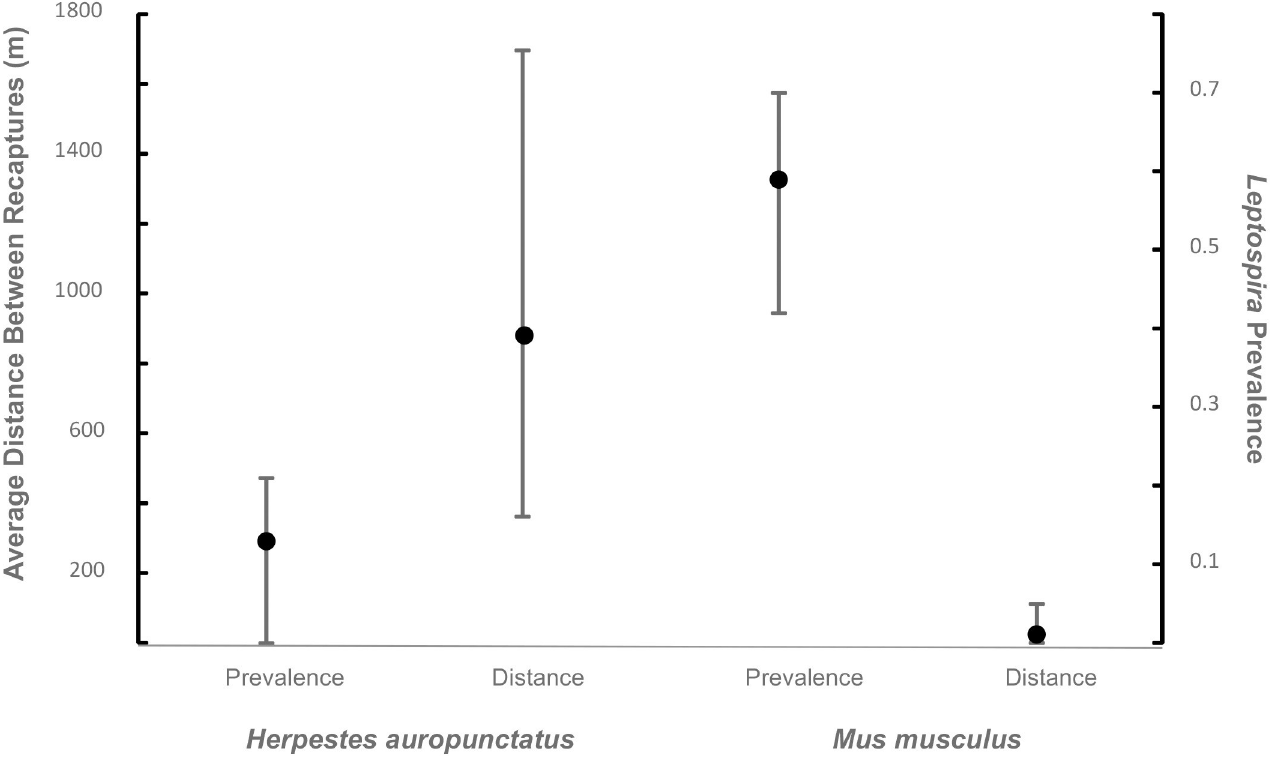
Fig 3. Comparison of Leptospira prevalence and movement distances of Herpestes auropunctatus and Mus musculus . Spatial movement data of H . auropunctatus was collected via a parallel telemetry sampling on four of the dairy farms in Puerto Rico that formed part of present study. Detailed results from this telemetry study forms part of a larger project about zoonotic diseases in cattle farms in the island and will be published elsewhere. The average distance between telemetry fixes among mongoose individuals equaled 362.61 meters, ranging from 362.61 meters– 1696.5 meters (extreme values represented with bars around point that represents average). Spatial movements of M . musculus were retrieved from a published review [69] that included capture-recapture studies for M . musculus in predominantly rural settings and included both feral and commensal house mice. The average distance between recaptures in this review equaled 25.27 meters, and the range was 0.9 meters to 112 meters (extreme values represented with bars around point that represents average). Prevalence estimates for both species represented in this graph are from the current study (extreme values represented by bars with averages as points).